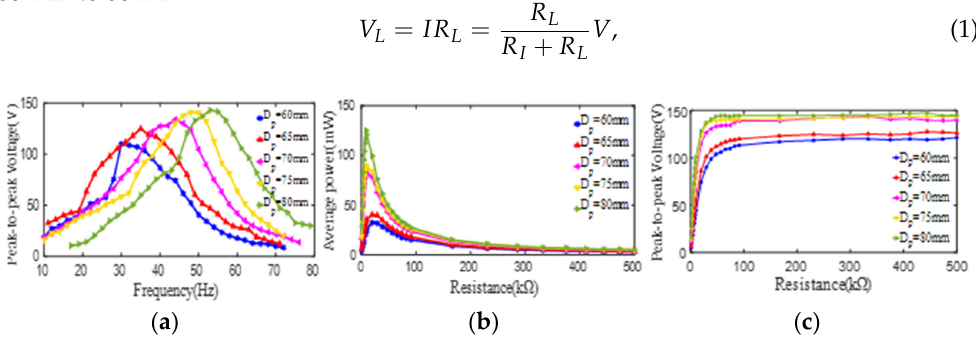
Figure 5. The effect of the outer diameter of the PZT4 patch on its peak-to-peak voltage and average power. ( a ) peak-to-peak voltage versus excitation frequency; ( b ) average power versus load resistance; ( c ) peak-to-peak voltage versus load resistance.